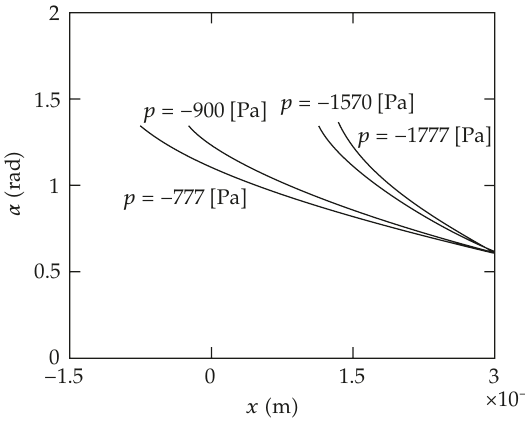
Figure 5: α versus x for p (cid:8) − 1777; − 1570; − 900; − 777 (cid:6) Pa (cid:7)